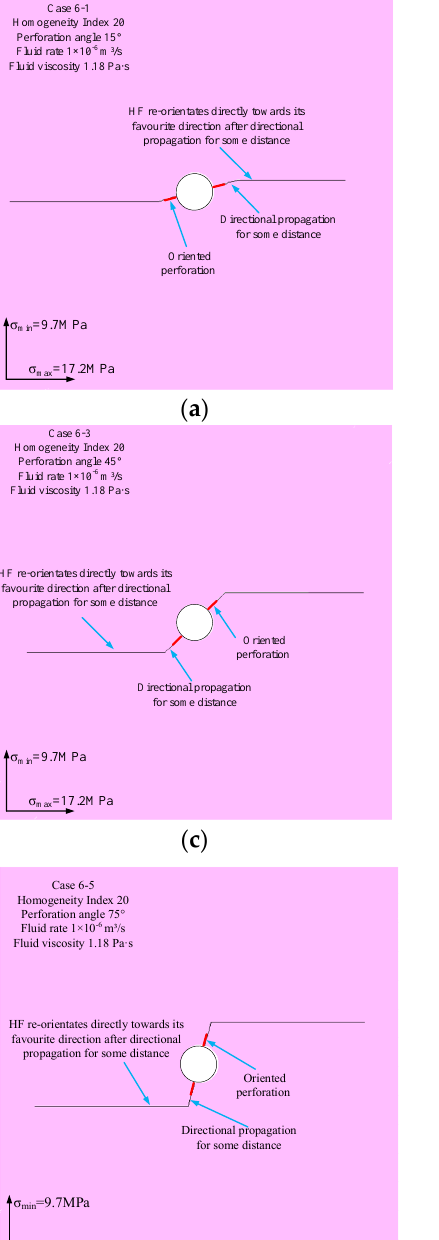
Figure 11. The relationship between HF re orientation and perforation angle when the homogeneity index is 2: ( a ) perforation angle is 15°; ( b ) perforation angle is 30°; ( c ) perforation angle is 45°; ( d ) perforation angle is 60°; ( e ) perforation angle is 75°.